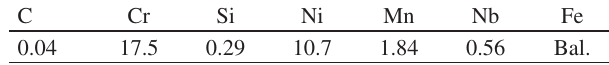
Table 1. Chemical composition (in wt. (%)) of the austenitic steel TP